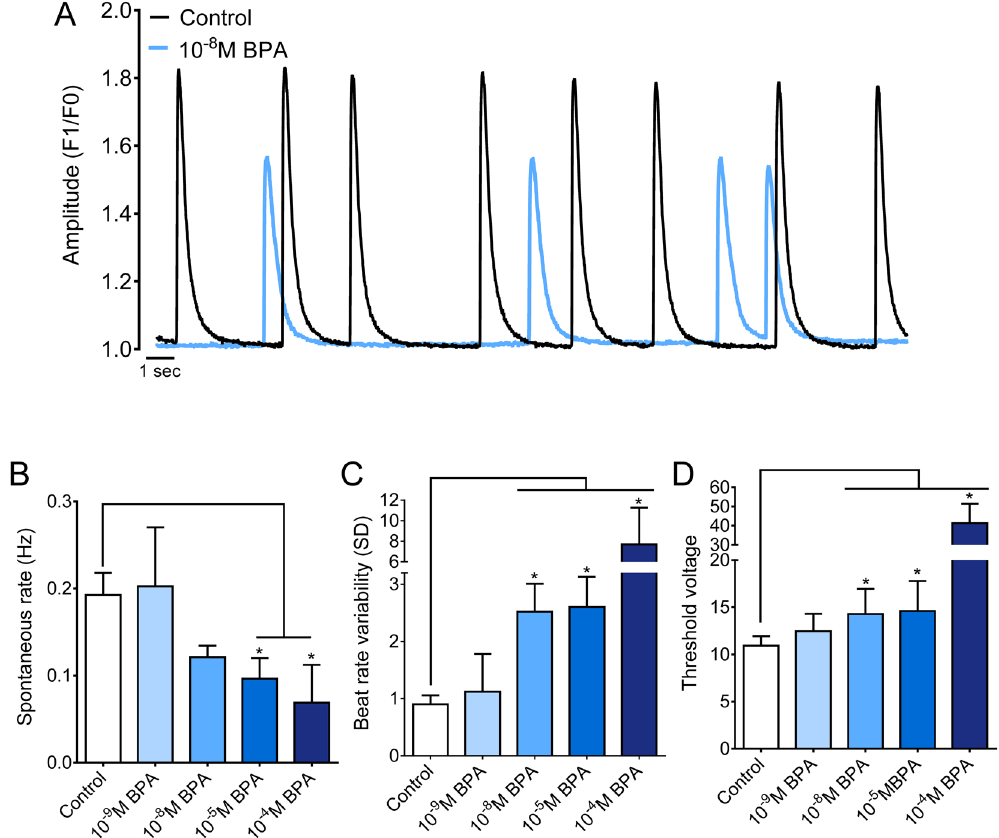
Figure 2. Acute BPA exposure decreases the spontaneous beating rate and cardiac excitability, and increases beat rate variability. Cardiomyocyte spontaneous beating rate was monitored following 15-min exposure to either vehicle control or BPA-supplemented media. ( A ) Representative example traces of neonatal cardiomyocytes under control conditions, or media supplemented with 10 − 8 M BPA. ( B,C ) Mean spontaneous beating frequency (Hz) and beat rate variability measurements (SD of interbeat interval). ( D ) Minimum threshold voltage required for excitation via field stimulation. AUF = arbitrary units of fluorescence, F1 = peak fluorescence amplitude, F0 = baseline fluorescence. * p ≤ 0.05, n ≥